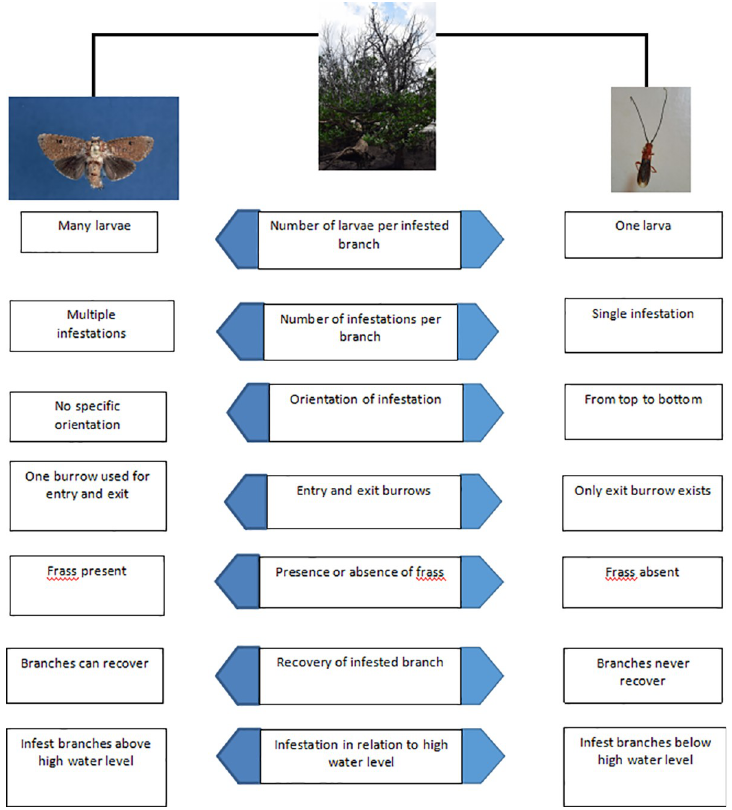
Fig 4. A scheme summarizing the differences of the infestation mechanisms employed by the two woodborers to infest S . alba in Kenya.